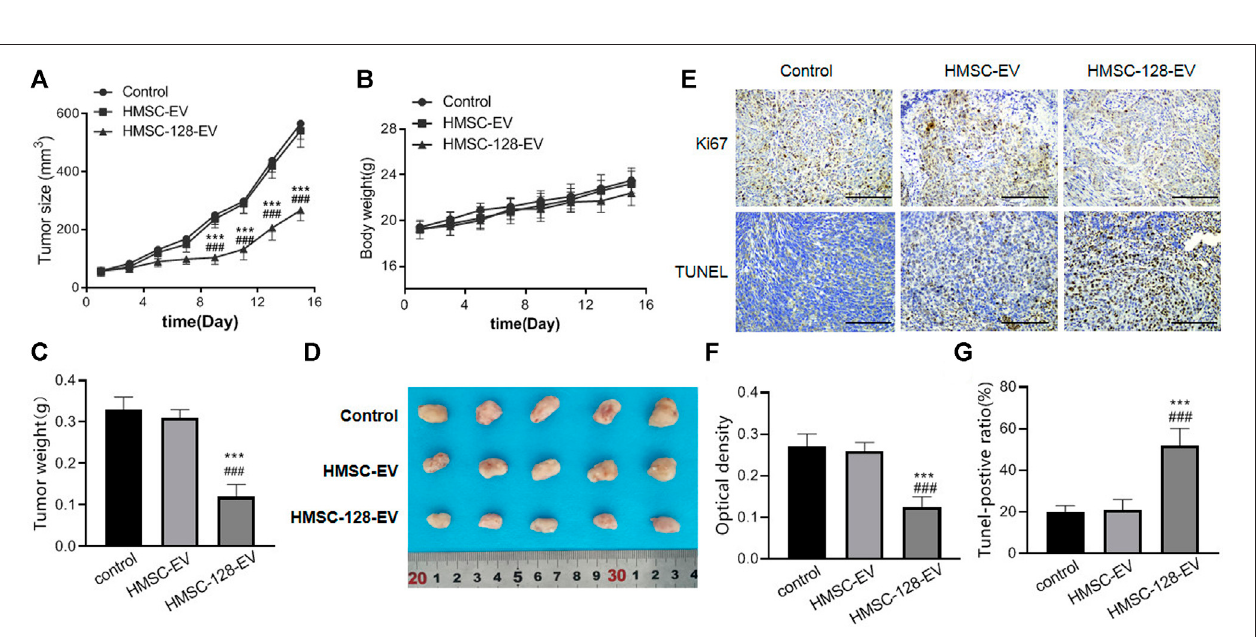
FIGURE 8 | HMSC-128-EV inhibited the growth of UCs in nude mice. (A, B) are line charts of the tumor volume and the body weight of nude mice in each group overtime,respectively. (C) istheweightoftumorsineachgroupafter16 daysoftreatment. (D) isatypicaldiagramoftumorsfromeachgroupafter16 daysoftreatment. (E) is the immunohistochemical staining results of Ki67 and TUNEL of tumor tissues in each group. (F, G) are the statistical results of Ki67 and TUNEL, respectively. HMSC-128-EV signi fi cantly inhibited the proliferation and promoted the apoptosis of UCs in nude mice. * p < 0.05, ** p < 0.01, *** p < 0.001 vs. Control. # p < 0.05, ## p < 0.01, ### p < 0.001 vs. HMSC-EV. Scale bars: 100 μ